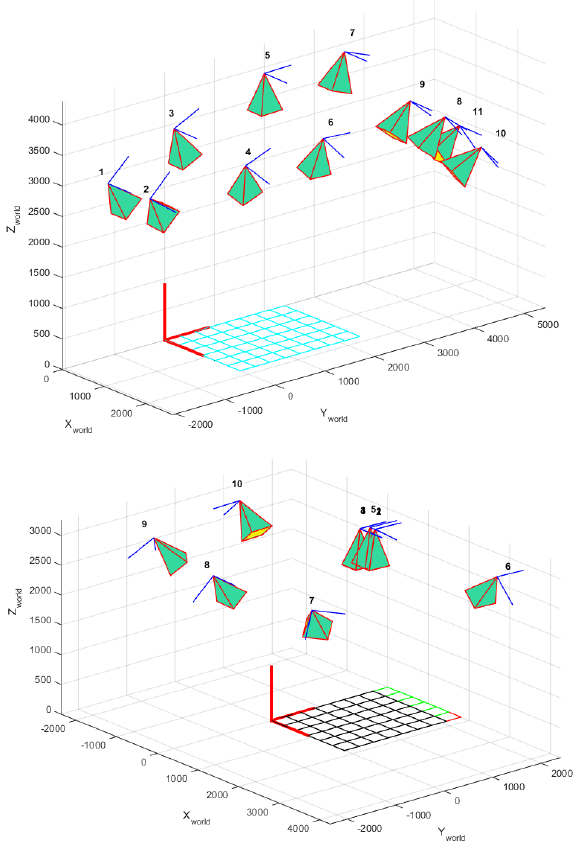
Figure 10. Orientation of the camera during indoor calibration (top) and outdoor calibration (bottom) Indoor calibration